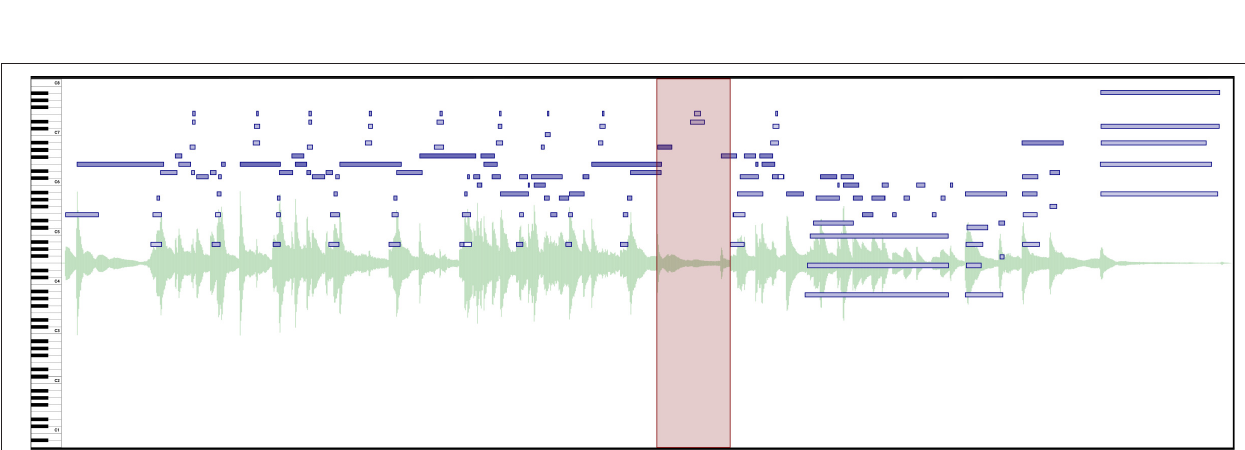
Frontiers in Psychology |